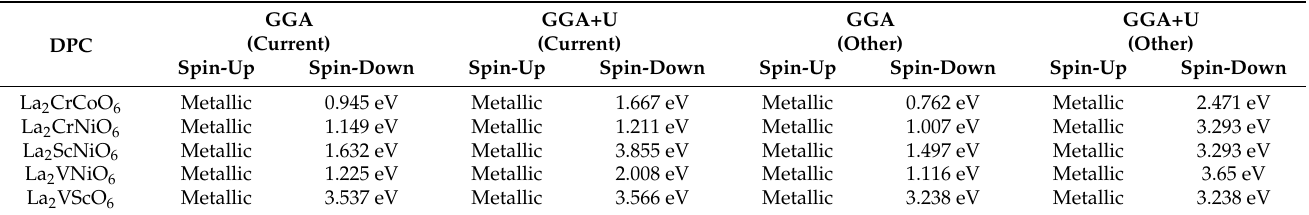
Table 1. Comparison of calculated electronic band gaps with previous electronic structure